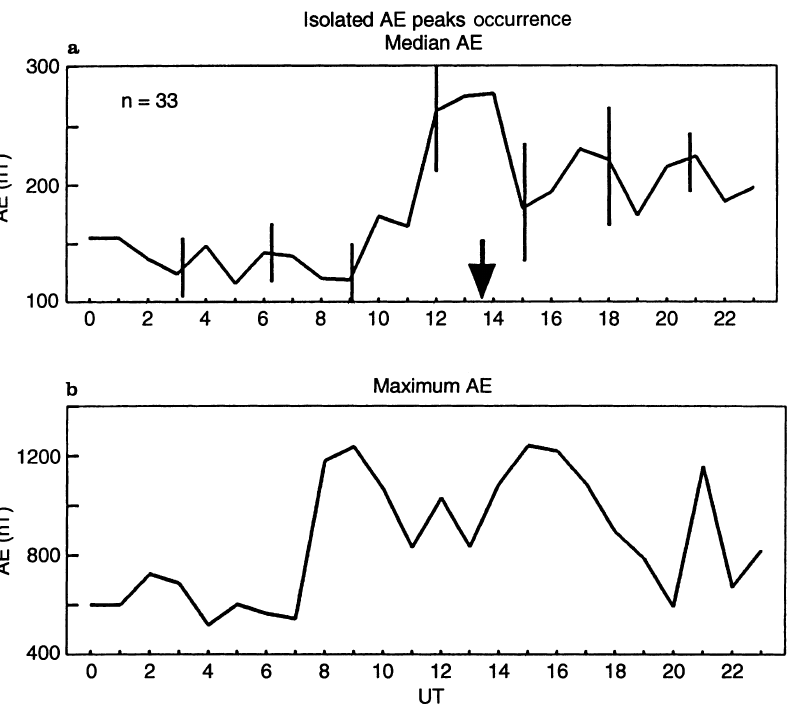
Fig. 2a,b. Statistical analysis of 33 isolated auroral substorm events. The error bars are indicated for the a median values. b All the days were scanned for maximum AE values